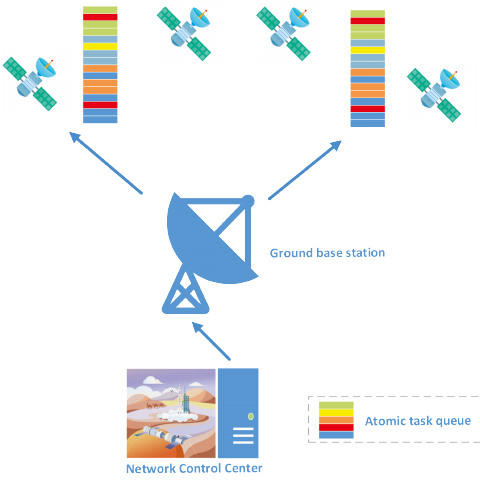
Figure 1. Overview of the task offloading